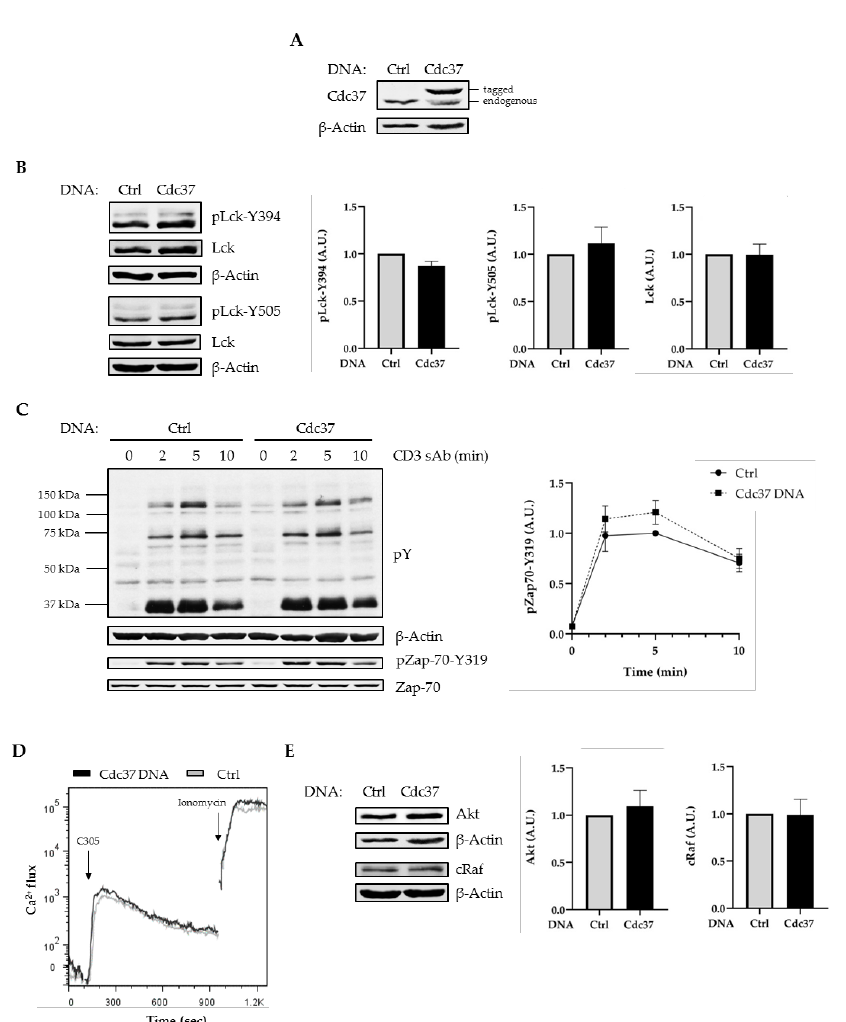
Figure 1. Cdc37 overexpression did not affect lymphocyte-specific protein tyrosine kinase (Lck) expression and T cell receptor (TCR) signaling. Jurkat T cells (JE6) were transfected with Ctrl or Cdc37 plasmids and cultured for 16 h. Cell lysates were analyzed by immunoblotting using the indicated Abs. ( A ) Immunoblot showing Cdc37 overexpression. ( B ) Immunoblots showing Lck expression and phosphorylation. Bands in ( B ) were quantified using the ImageStudio software and values were normalized to the corresponding total protein signal or β -actin signal. ( C ) After 16 h, cells were stimulated with soluble CD3 (sAbs) (clone UCHT1) for the indicated times. Subsequently, lysates were analyzed by immunoblotting using the indicated Abs. Bands in ( C ) were quantified as described in ( B ). The graph shows the phosphorylation level of zeta chain of T cell receptor-associated protein kinase 70 (Zap-70) as arbitrary units ± SEM (standard error of the mean) of four independent experiments. ( D ) JE6 cells were incubated with Indo-1AM, stimulated with the TCR clonotypic antibody C305, and Ca 2+ flux was measured by flow cytometry. Ionomycin is used as positive control to induce maximum Ca 2+ flux. ( E ) Immunoblots showing Akt and cRaf expression. Graphs show the expression levels of indicated molecules as arbitrary units ± SEM of three independent experiments. Significant p -values were calculated using the Student’s t